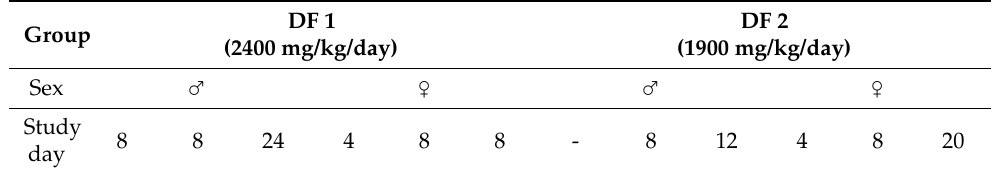
Table 4. First day a pharmacobezoar was visible by MRI in the stomach of rats in the dose finding study. Dose of spray-dried amorphous solid dispersion given in brackets.